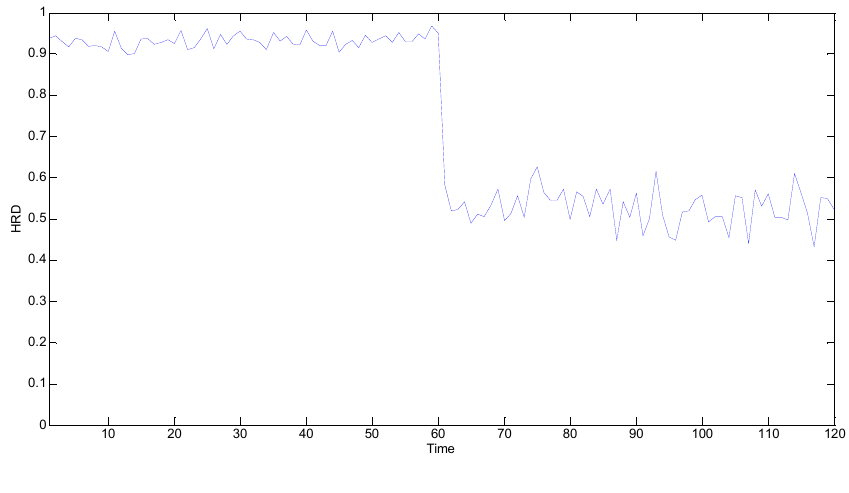
Figure 13. HRD s of multifunctional self-validating sensor when MQ2 is